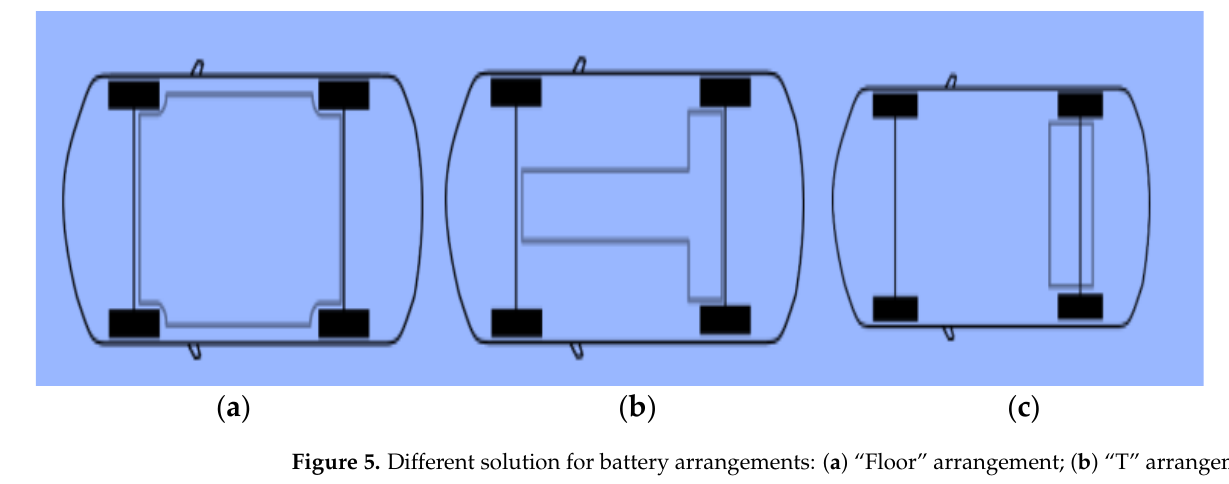
Figure 5. Different solution for battery arrangements: ( a ) “ Floor ” arrangement; ( b ) “ T ” arrangement; ( c ) “ Rear ” solution.